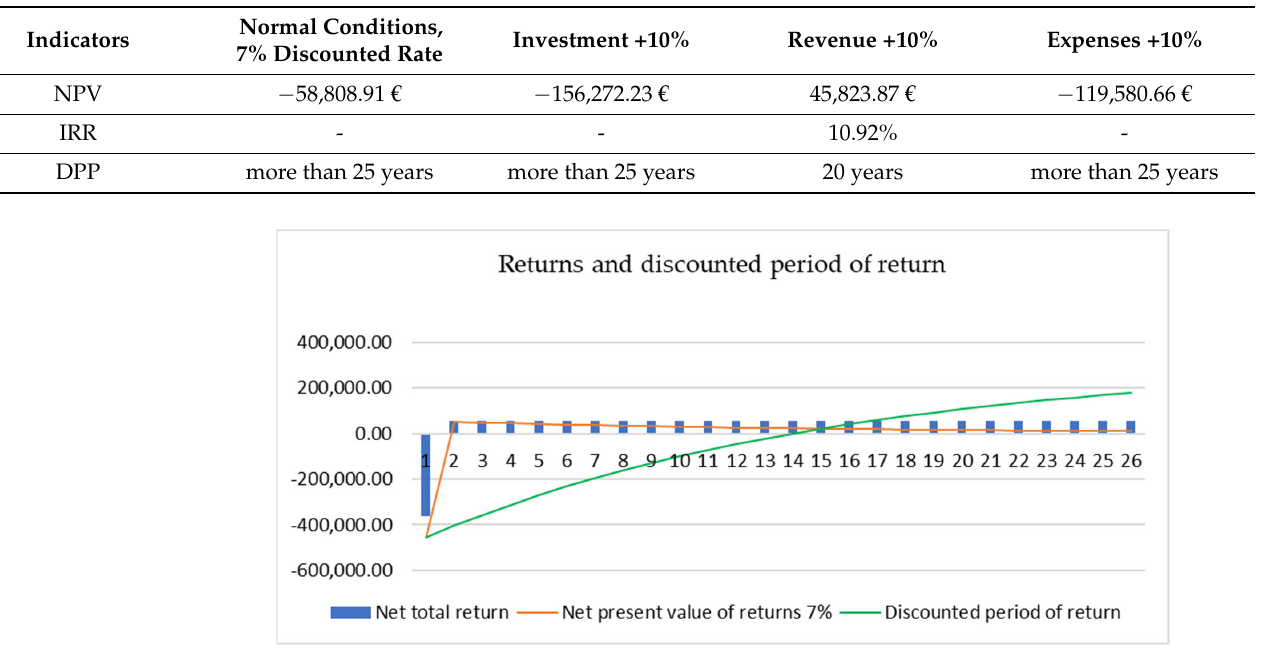
Table 6. Financial indicators for Naklo 2.